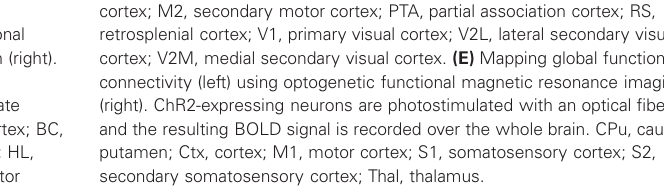
FIGURE 1 | Continued HL, hindlimb area of the sensorimotor cortex. (D) Mapping inter-regional functional connectivity (left) using VSD imaging and ChR2 stimulation (right). Multiple regions of interest are targeted for photostimulation and the resulting VSD response (change in fluorescence) is recorded to indicate strength of connections between functional regions. A1, auditory cortex; BC,